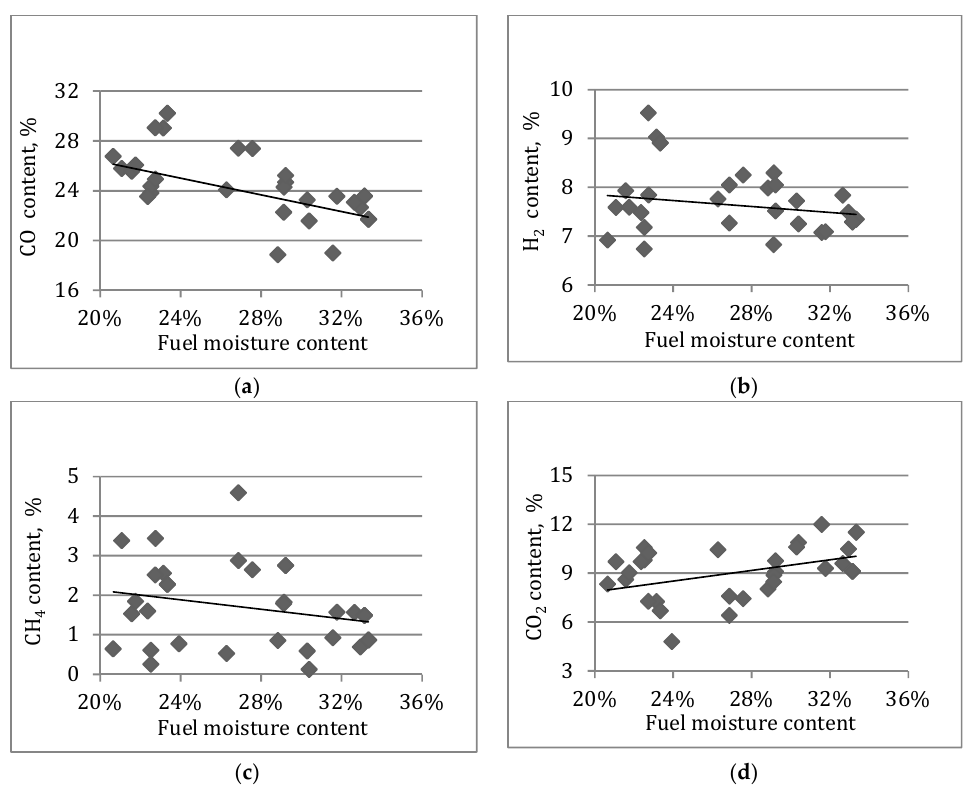
Figure 5. Variation of gas contents with fuel moisture content: ( a ) CO, ( b ) H 2 , ( c ) CH 4 , ( d ) CO 2 . The gas content is on a volume ( v / v ) basis. Tests done at the UBC gasifier.